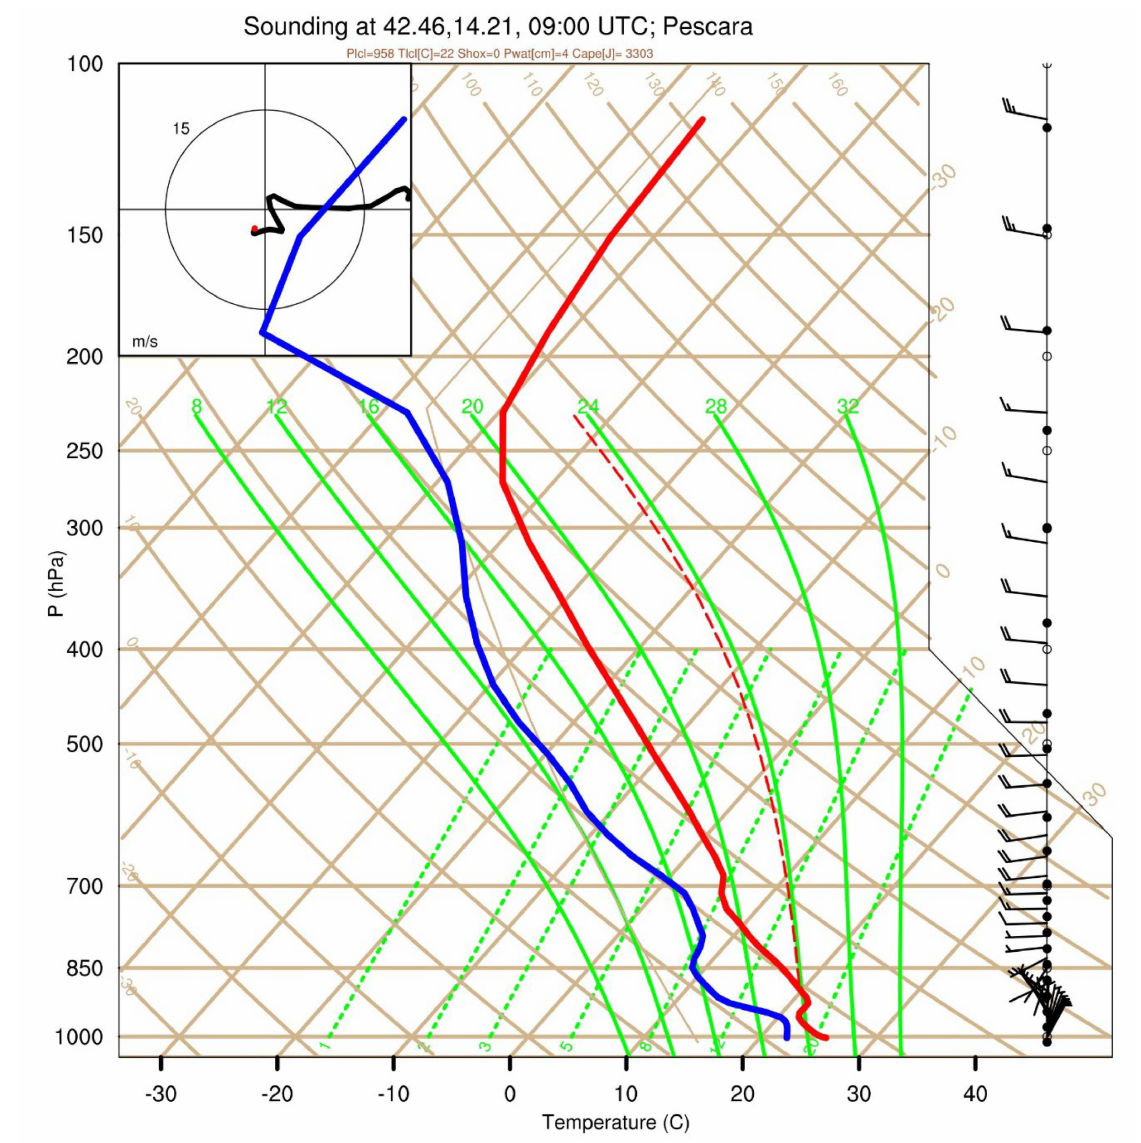
Figure 11. Run GFS09. Skew-T and hodograph at the grid point closest to Pescara at 09:00 UTC, 10 July